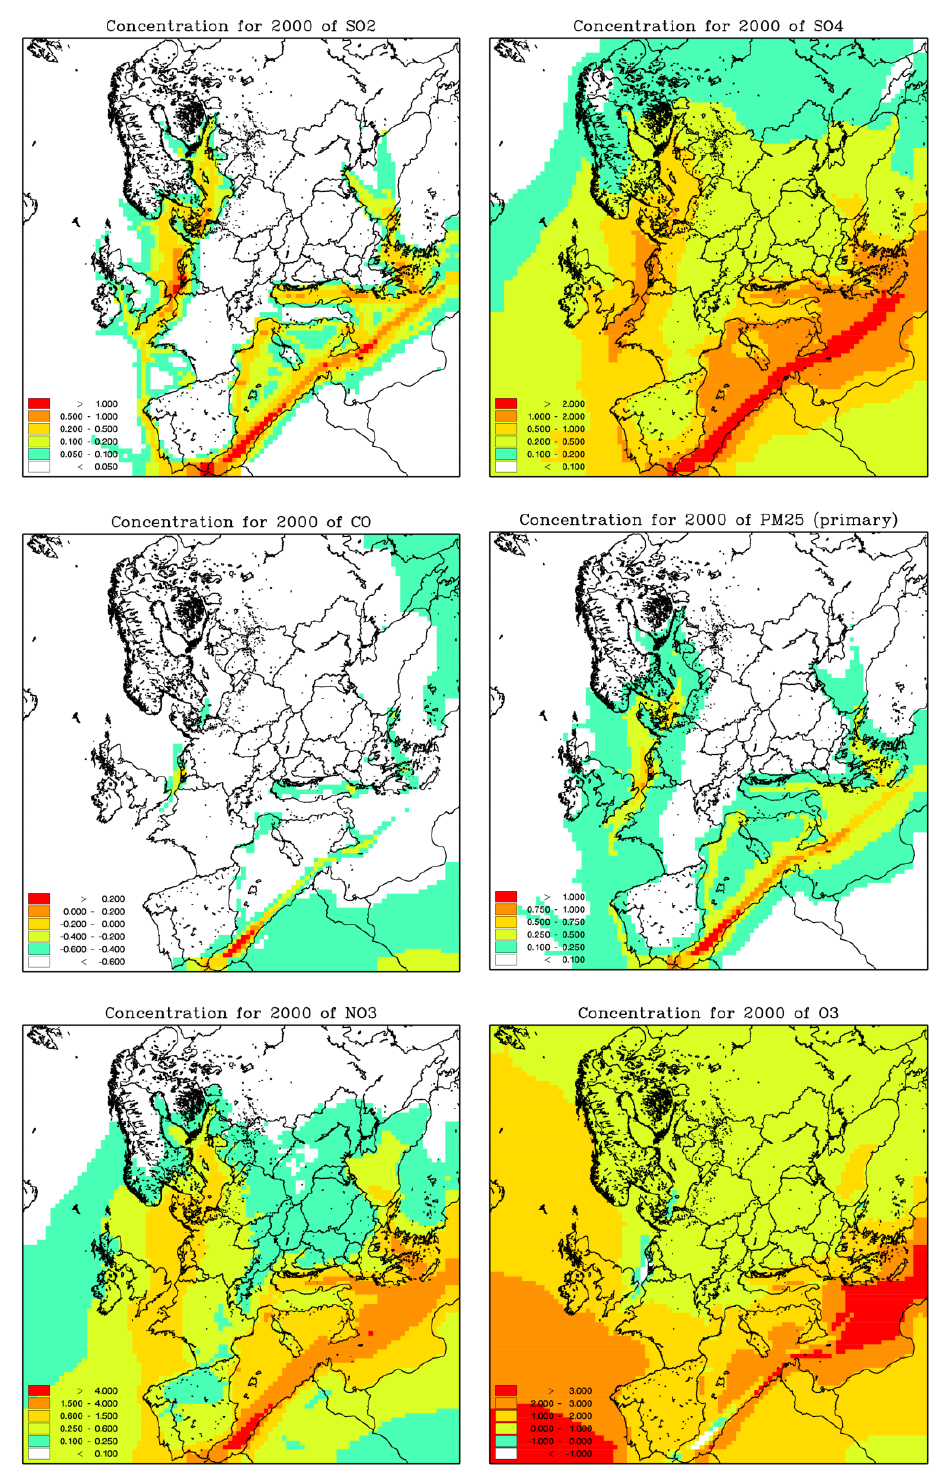
Fig. 5. Contribution to the mean annual air pollution levels ( δ -concentrations) calculated using the DEHM model due to emissions from the Northern Hemisphere from international ship traffic for the year 2000. The compounds are SO 2 [ppb], SO 2 − (primary part) [µgm − 3 ], NO − [µgm − 3 ] and O 3 [ppb]. Results are shown for DEHM domain number 3